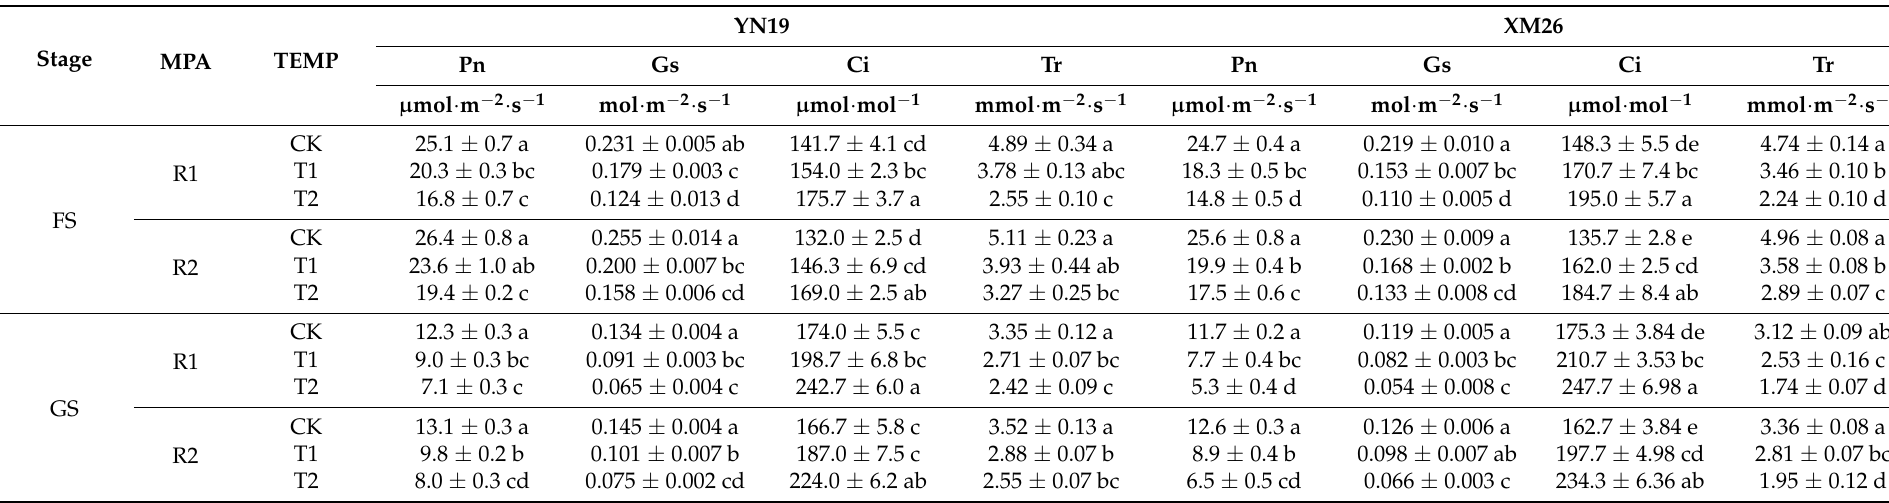
Data represent mean ± SE ( n = 3). Different letters following the data within each column indicate significant differences at p < 0.05. Abbreviations: YN19 = Yannong19; XM26 = Xinmai26; Pn: net photosynthetic rate; Gs: stomatal conductance; Ci: intercellular carbon-dioxide concentration; Tr: transpiration rate; MPA = the methods of phosphorus application; TEMP = temperature; FS = flowering stage; GS = grain-filling stage. R1 and R2 represent traditional phosphorus application and optimized phosphorus application, respectively. CK, T1 and T2 represent 11 ◦ C, 4 ◦ C and − 4 ◦ C,